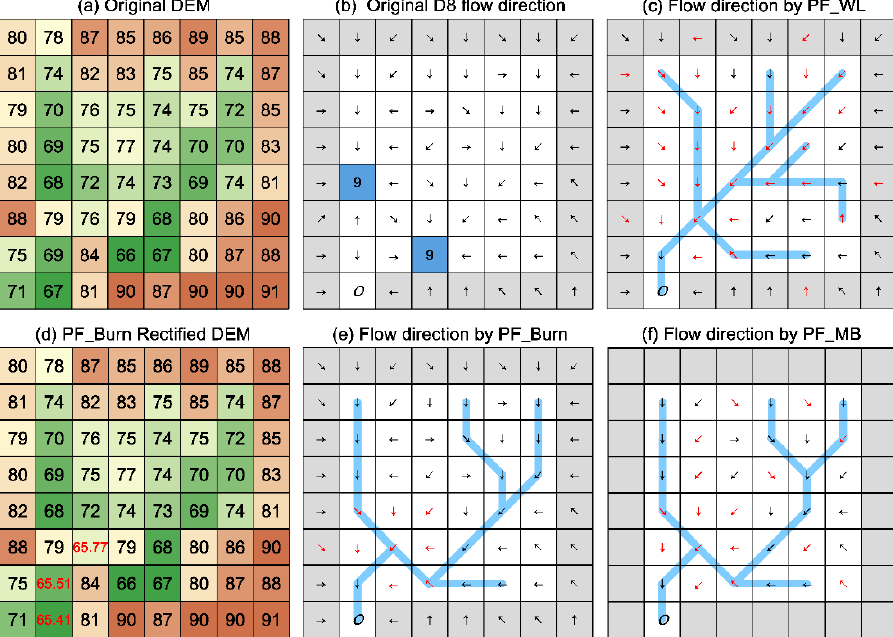
Figure 1. Illustration of various depression treatments. ( a ) An 8 × 8 sample extracted from a 90-m DEM of the Sichuan Basin, which is the study area (see Section 3.1), and its associated D8 steepest downhill flow directions ( b ). ( c ) Flow directions determined by the PF_WL algorithm. ( d ) Depressionless DEM produced by PF_Burn algorithm (the new variant). Flow directions determined by the PF_Burn ( e ) and the PF_MB ( f ) algorithms. Red-colored arrows indicate alterations of the original D8 flow directions as shown in Figure 1b. The dark-shaded cells are border cells.